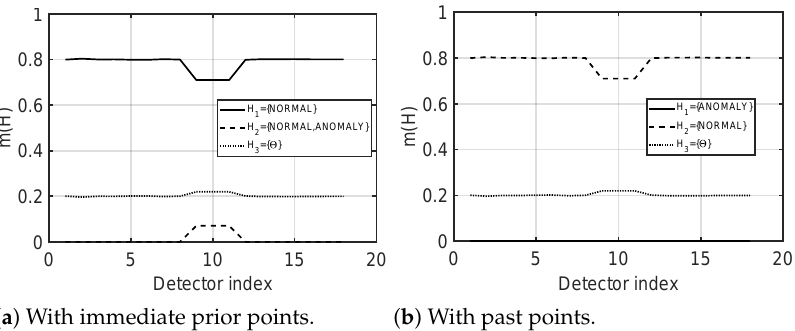
Figure 17. Detectors input compromised by attacker’s estimation via linear